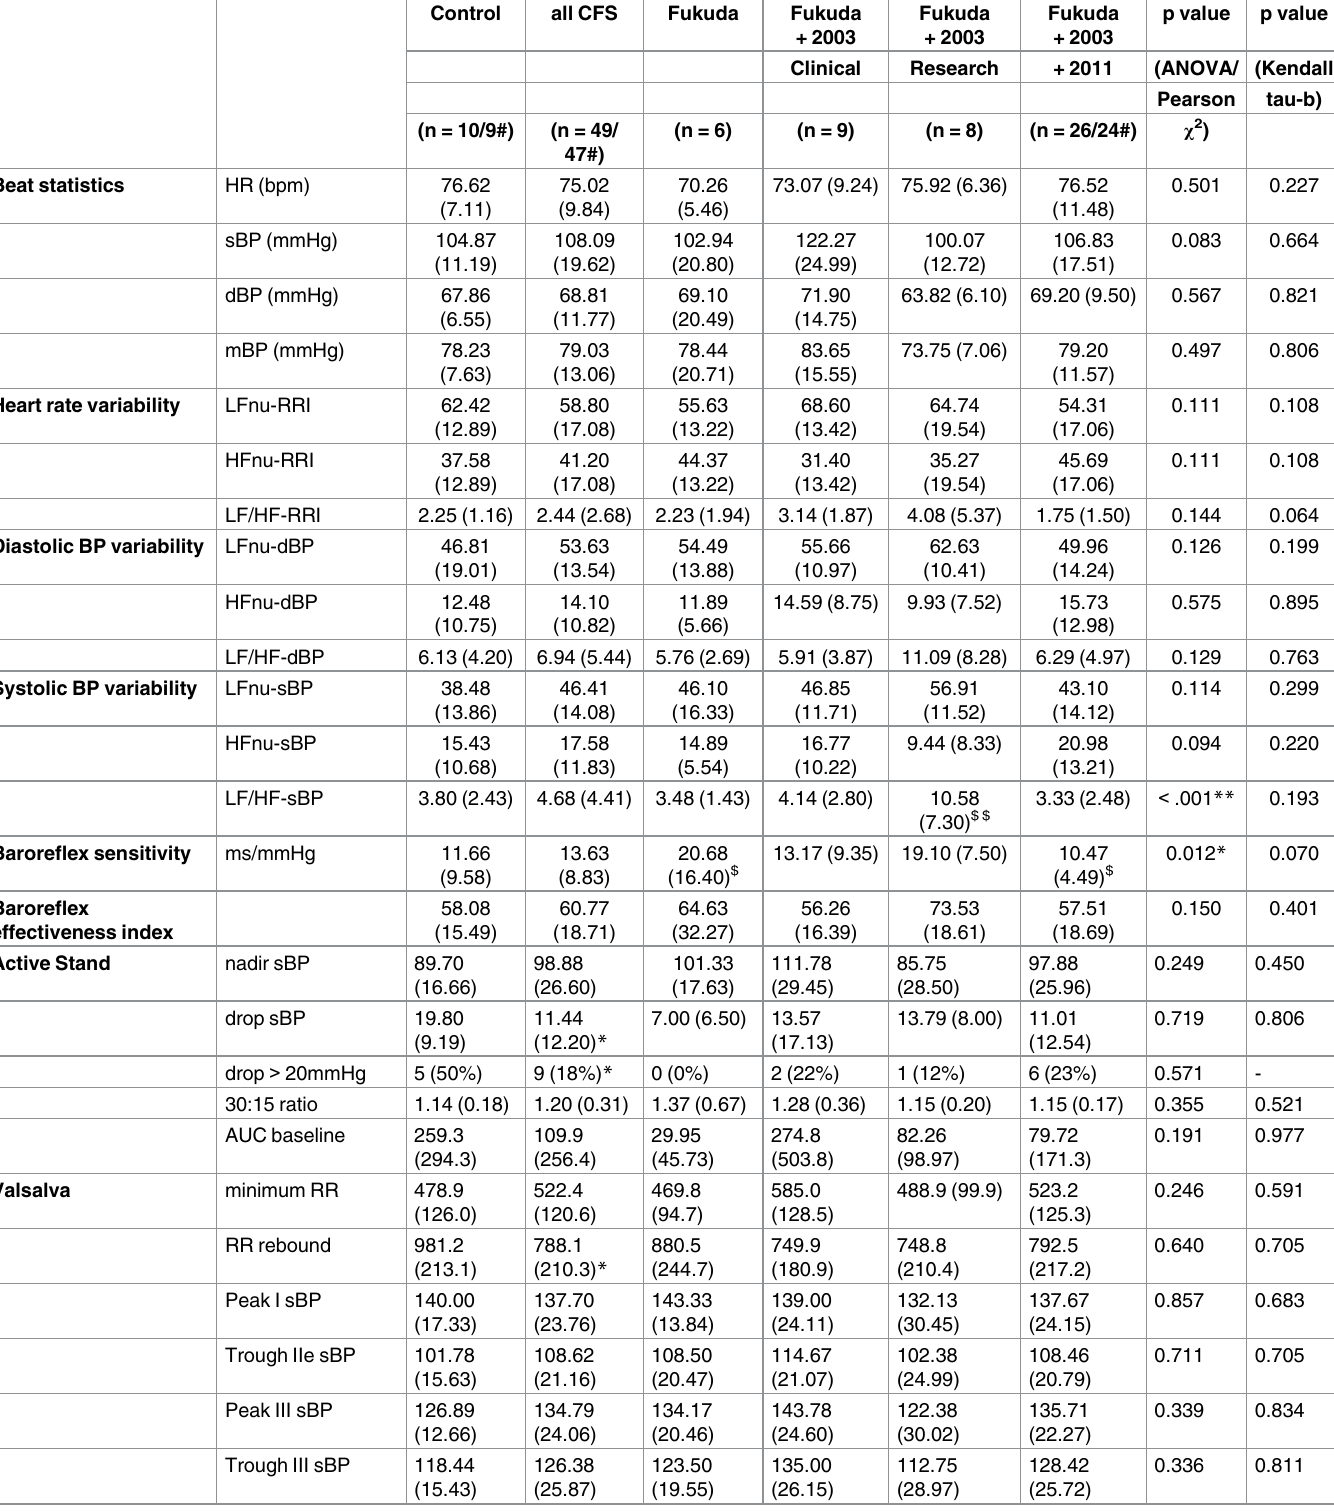
Table 4. Autonomic function (heart rate and blood pressure variability and beat statistics, active stand and Valsalva) by